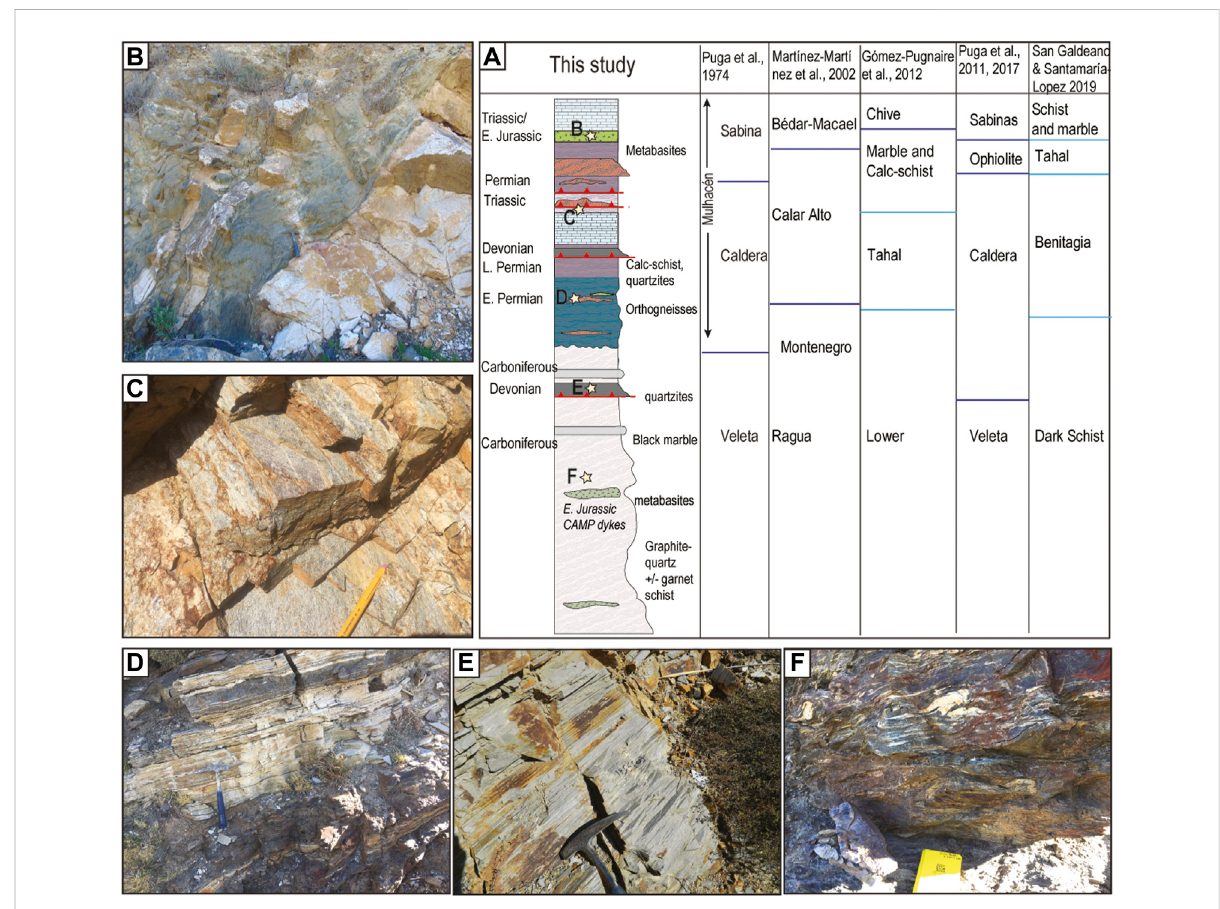
FIGURE 2 Structural column from the NFC including interpretations in this study, previous subdivisions, and sample pictures from the different structural levels. NFC subdivisions from previous studies were compiled from Sanz de Galdeano & Santamaría-López, (2019). (B) Metabasites/marble contact from the upper parts of the Mulhacén succession, (C) Triassic light garnet mica schist, (D) Permian orthogneiss bodies intercalated among garnet mica schist, (E) Devonian quartzites, and (F) graphitic mica schist from the Veleta